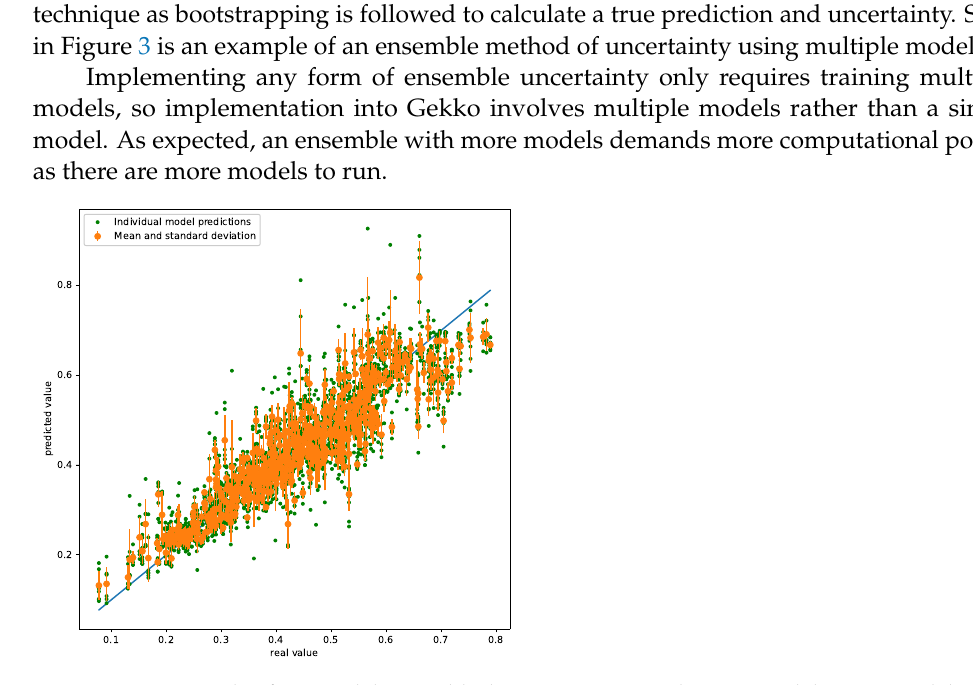
Figure 3. An example of a 6-model ensemble, between 3 GPR and 3 SVR models. Low model count is used for graphical purposes; true ensembles would demand much